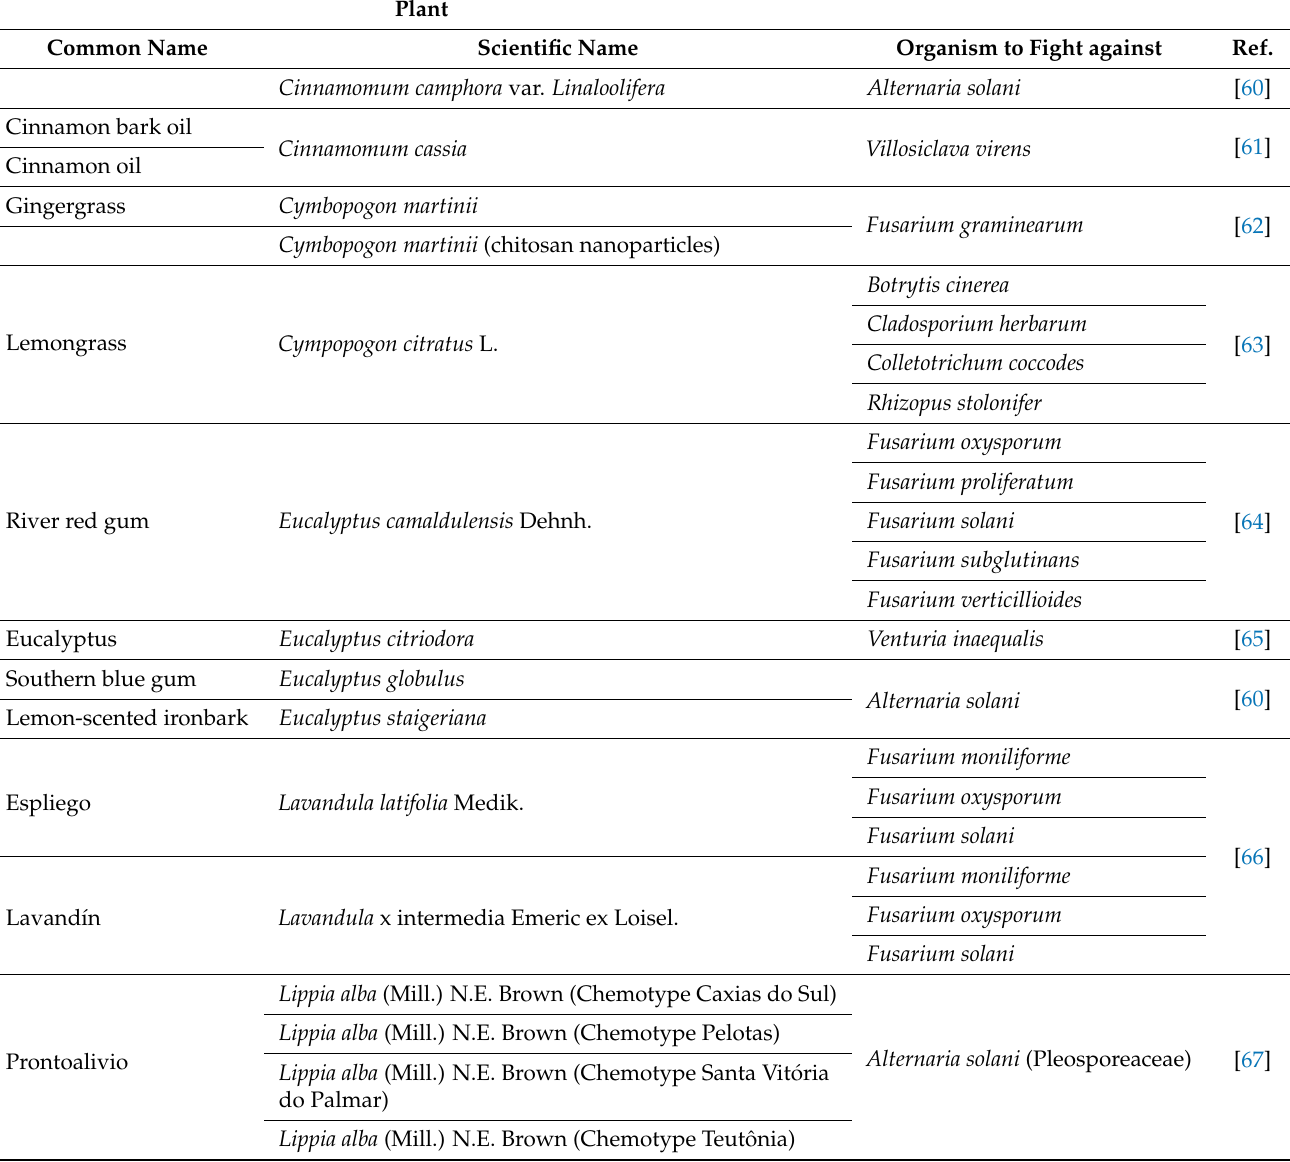
Table 2. Plants and essential oils that could be used for their antifungal properties.